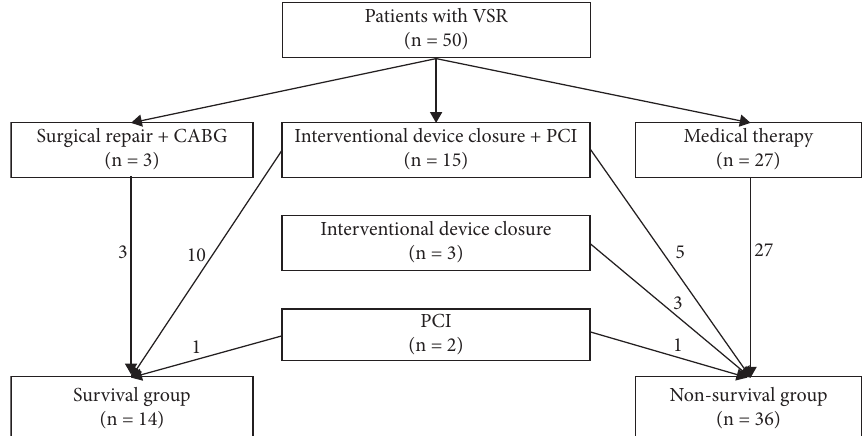
Figure 1: Flowchart for treatment of patients with ventricular septal rupture. VSR, ventricular septal rupture; PCI, percutaneous coronary intervention; CABG, coronary artery bypass